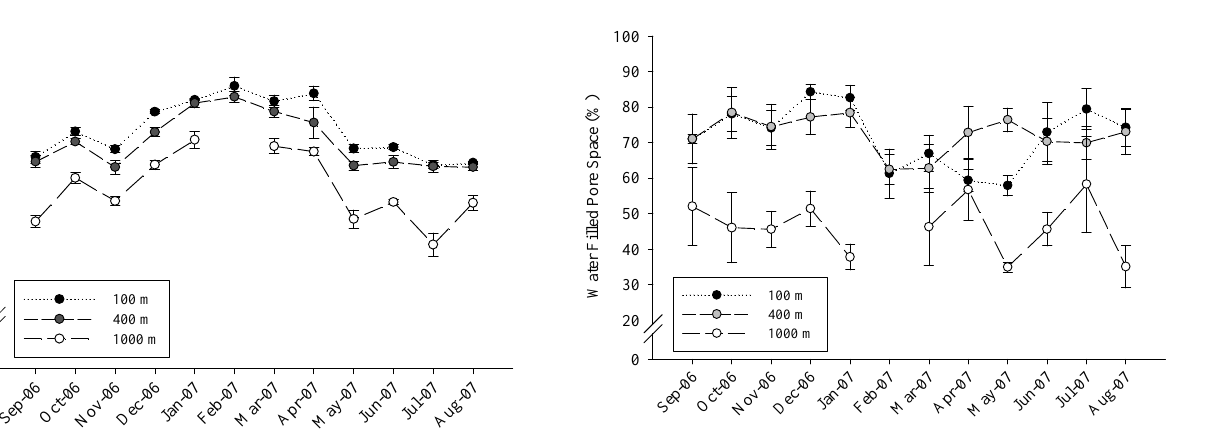
Fig. 1. Monthly soil temperatures (2cm depth) at the three different elevations. Values represent the mean of four replicate plots per elevation, and error bars represent the standard error. Because of weather conditions it was not possible to access the sites at altitude 1000m in February 2007.